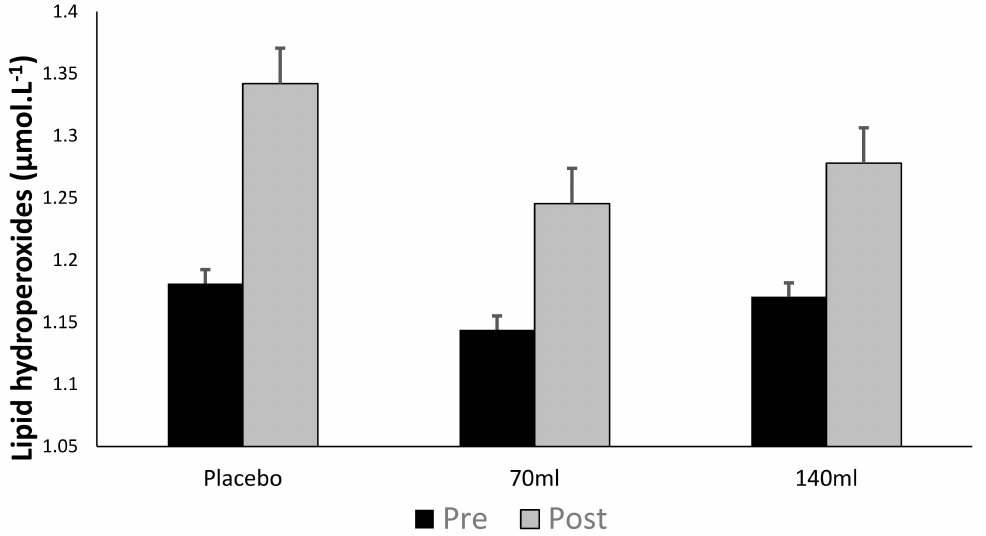
Figure 3. Lipid hydroperoxides (mean ± SD) at pre- and post-exercise across groups ( n = 10).